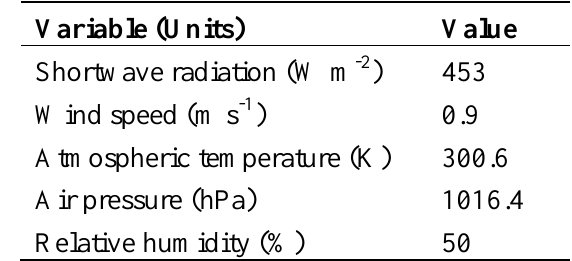
Table 2. Summary of the meteorological conditions of the analysis in Tainan City at 1100 TST on March 6, 2001.